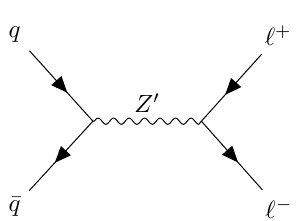
Figure 1 . Feynman diagram for s -channel annihilation of a quark-antiquark pair into leptons mediated by a Z 0 at leading order. Diagram created with TikZ-Feynman